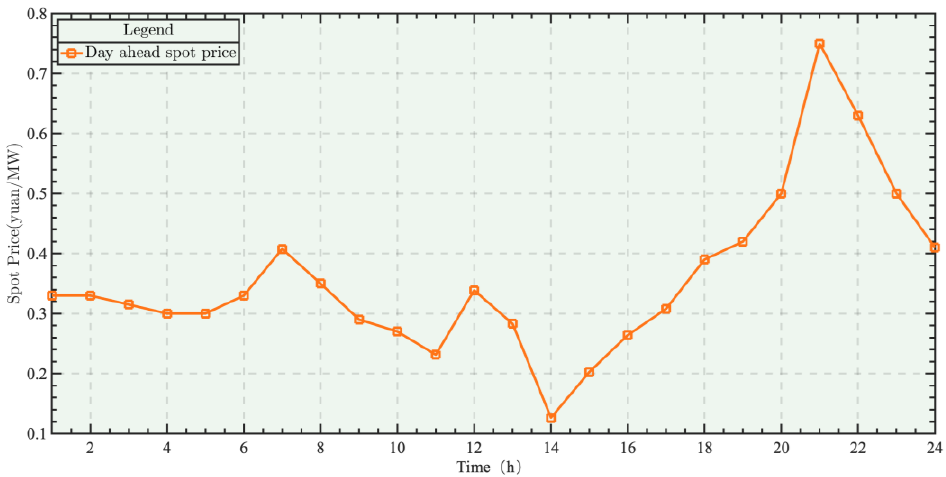
Figure 4. Forecasted day-ahead market price. Table 4. Case study